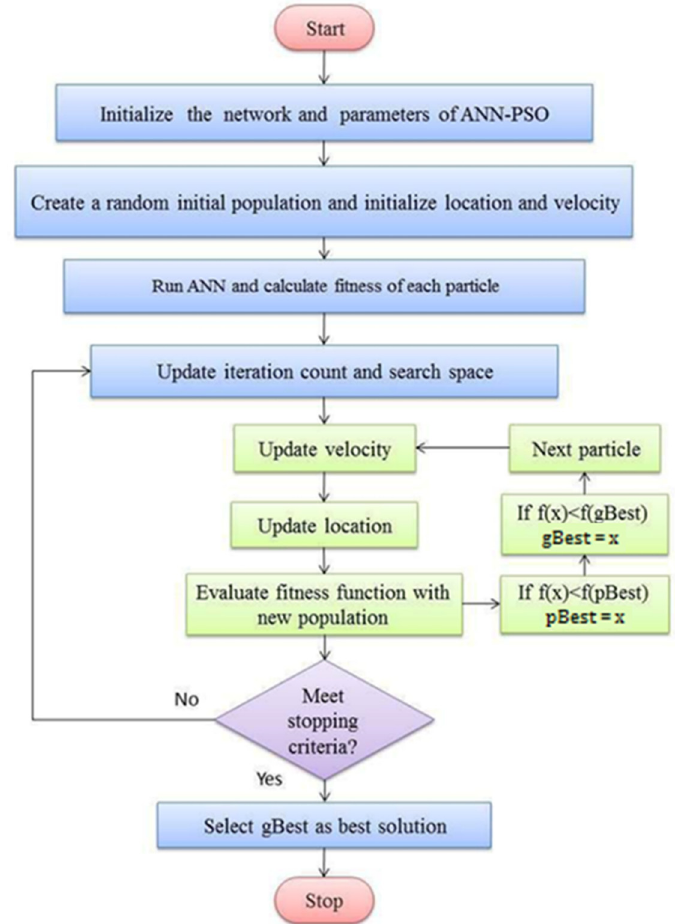
Figure 4. ANN ‐ PSO algorithm flowchart. Figure 4. ANN-PSO algorithm